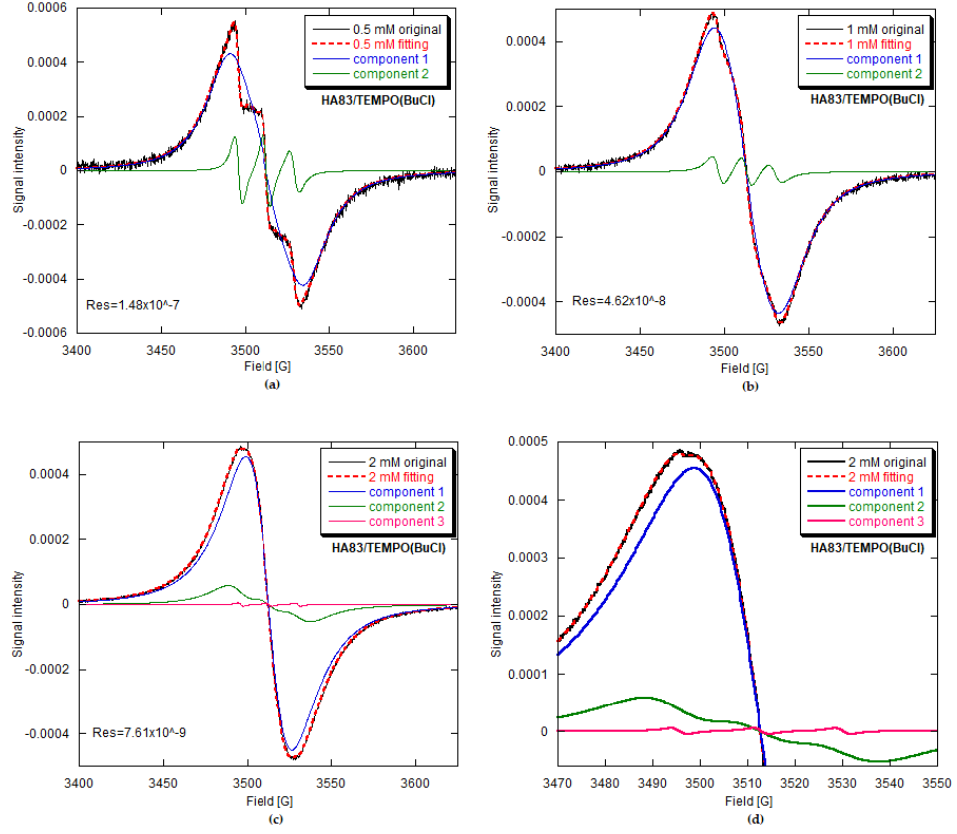
Figure 5. The original and simulated EPR spectra of the HA83/TEMPO(BuCl) composites prepared using three different initial TEMPO concentrations in BuCl: ( a ) 0.5 mM; ( b ) 1 mM; ( c ) 2 mM; ( d ) a magnified region of the 2 mM spectrum, justifying a contribution from the third spectral component.